Question: Based on the figure, does the quantity rise or fall?
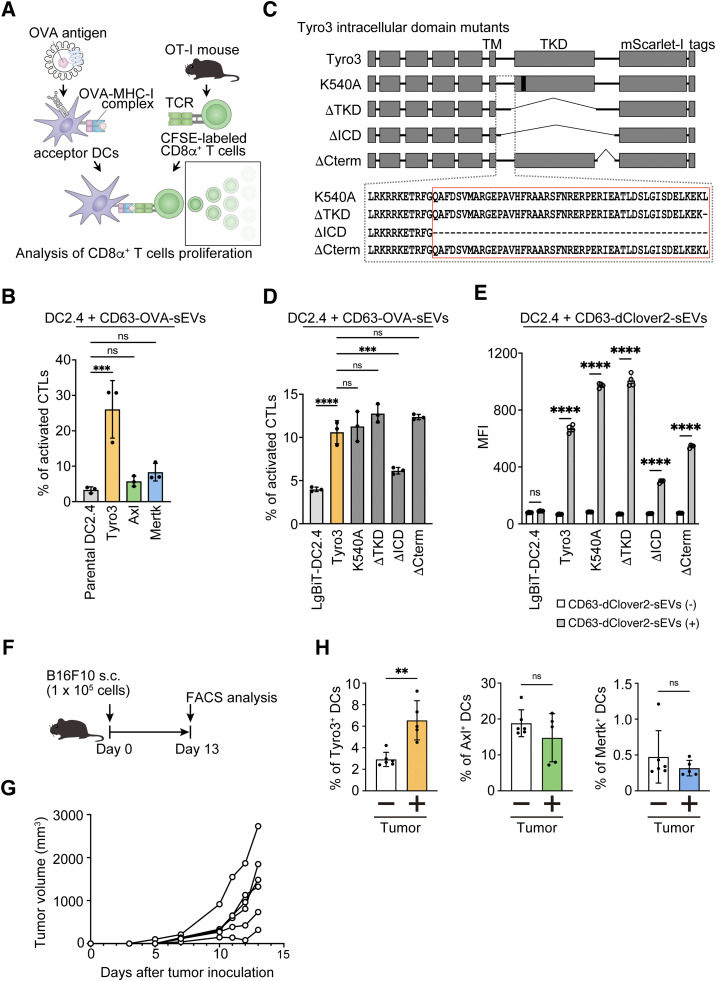
Answer: increasing